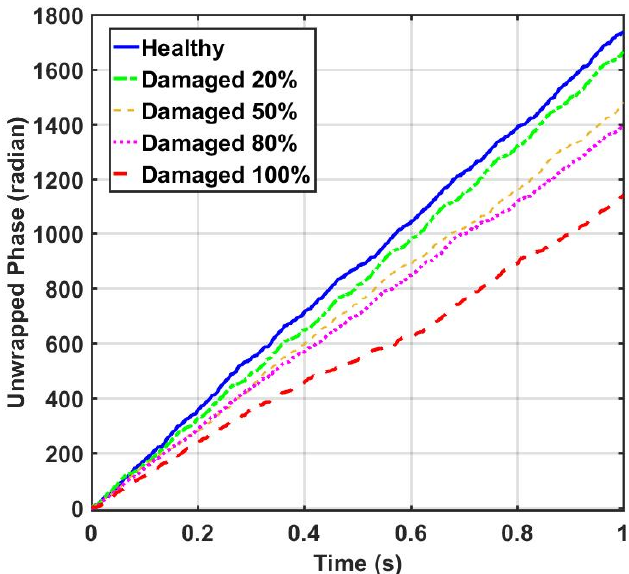
Table 1. Damage index (DI) results based on the energy, instantaneous amplitude (IA), and unwrapped phase of IMFs for the different damage levels.